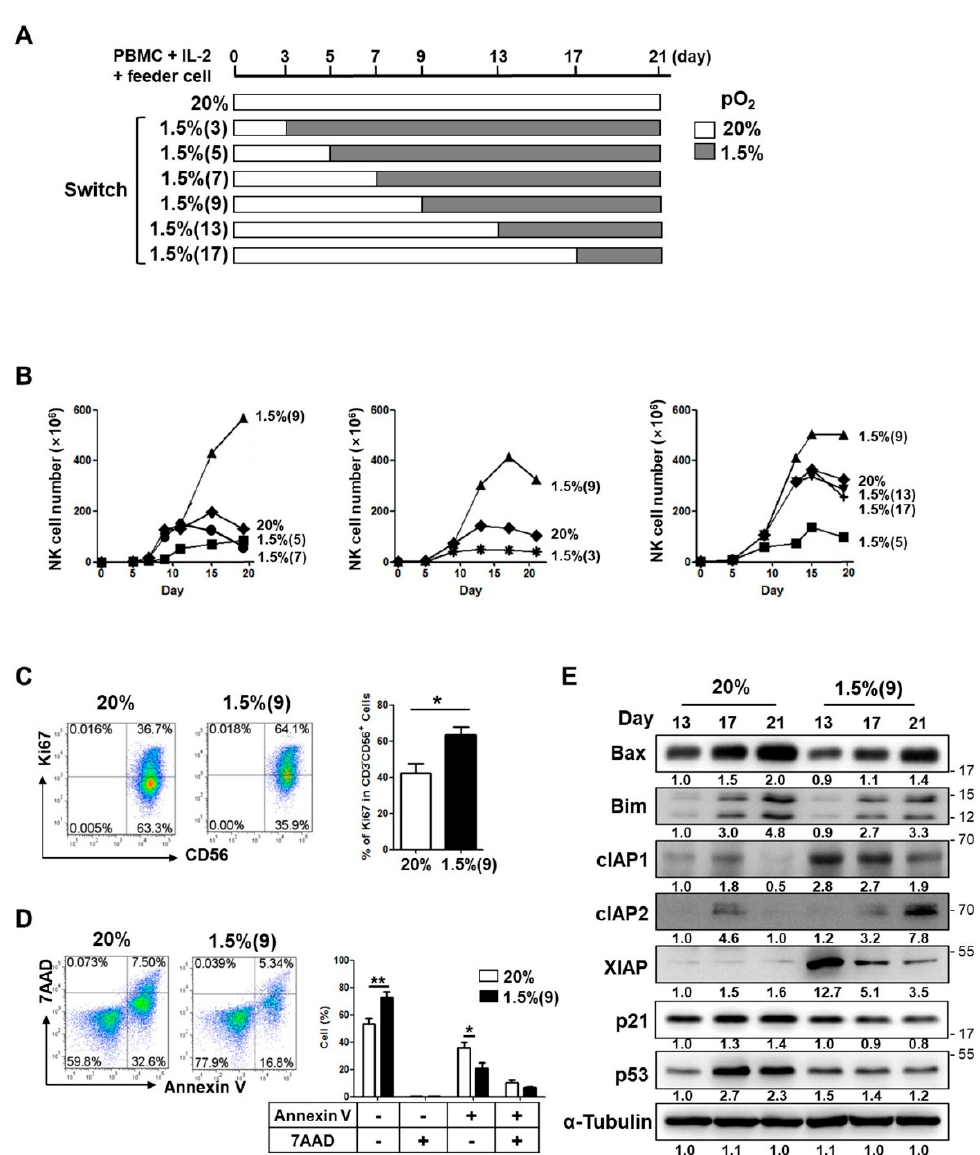
Figure 2. Time ‐ controlled exposure of NK cells to hypoxia can lead to a highly proliferative phenotype. ( A ) Schematic representation, showing the dates of normoxia ‐ to ‐ hypoxia switch, during NK cell culture ex ‐ vivo. ( B ) Representative cell counting results over the course of 21 ‐ day culture, under normoxia and hypoxia, are shown. ( C ) Left , rate of proliferation of NK cells in normoxic and hypoxic cultures was assessed by Ki67 staining and analyzed by flow cytometry. Right , the levels of Ki67 + population, shown in left panel, from six independent experiments are plotted as bar graphs (mean ± SEM *, p < 0.05; **, p < 0.01). ( D ) Left , normoxic and hypoxic cultures of NK cells were stained with annexin V/7AAD and analyzed by flow cytometry. Number in each quadrant indicates the percentage of annexin V + and/or 7AAD + population. Right , levels of annexin V + and/or 7AAD + population, shown in left, from six independent experiments are plotted as bar graphs. Data are presented as the mean ± SEM. *, p < 0.05; **, p < 0.01. ( E ) Western blot analyses were performed to assess time ‐ dependent changes of pro ‐ apoptotic (Bax and Bim), anti ‐ apoptotic (cIAP1, cIAP2, and XIAP), and cell cycle arrest (p21 and p53) marker expression in normoxic and hypoxic cultures of NK cells. Density of each band was normalized to that of α‐ tubulin. Data shown are representative of three independent